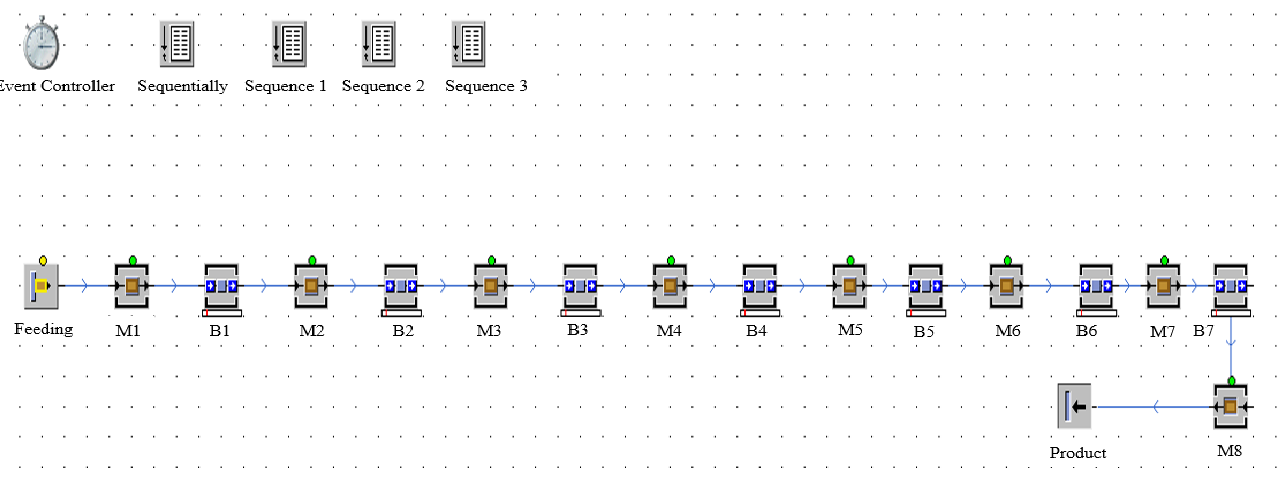
Figure 17. Simulation model of a mobile phone assembly line.